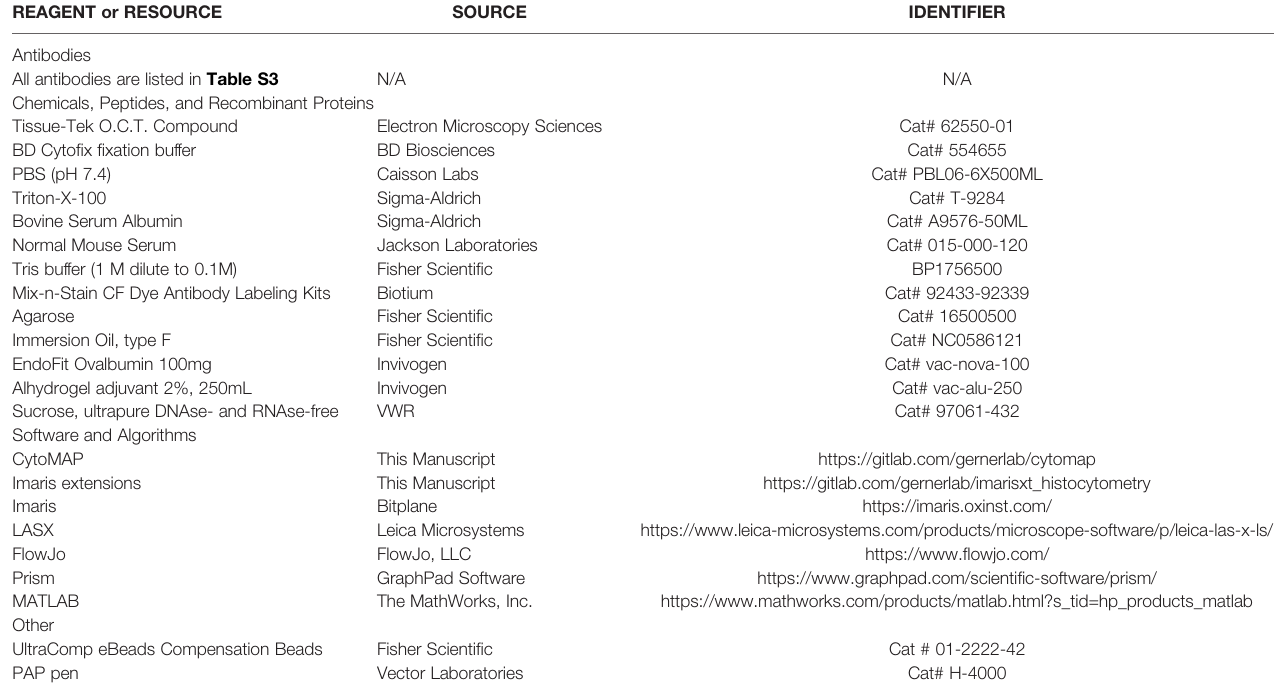
TABLE 1 | Key resources and software. REAGENT or RESOURCE Antibodies All antibodies are listed in Table S3 N/A N/A Chemicals, Peptides, and Recombinant Proteins Tissue-Tek O.C.T.